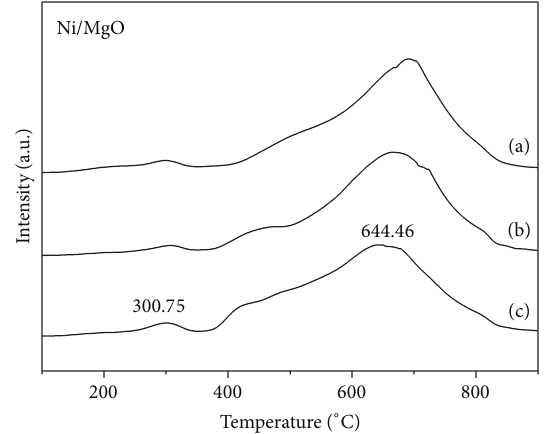
Figure 1: H 2 -TPR profiles of Ni/MgO catalysts with various calci- nation temperatures. (a) 400 ∘ C; (b) 450 ∘ C; and (c) 500 ∘ C.